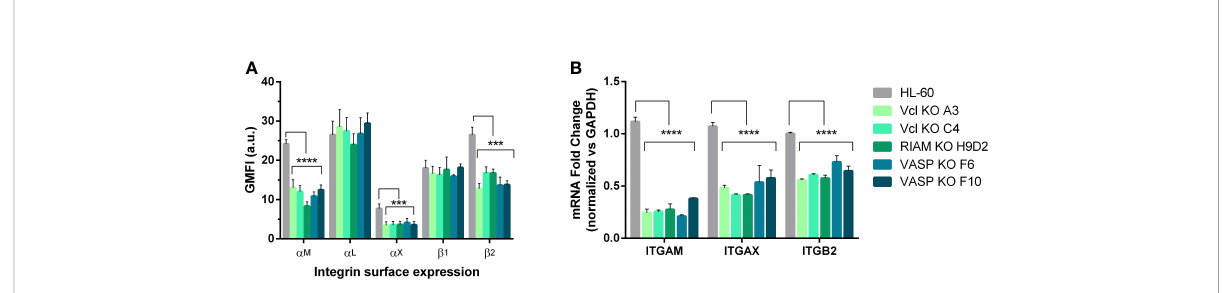
FIGURE 2 a a M and X expression is dependent on Vinculin, RIAM and VASP expression. (A) Vinculin (Vcl), RIAM and VASP knockout cell lines and HL-60 parental cells were differentiated into neutrophilic-like cells with 1 m M all- trans retinoic acid (RA) and stained with monoclonal antibodies speci fi c for a M , a L, a X, b 1 , b 2 integrin subunits. The geometric mean fl uorescence intensity (GMFI) was obtained by fl ow cytometry and data represented as relative to HL-60 levels and are from 24 independent experiments done in duplicate. (B) Expression of ITGAM ( a M ), ITGAX ( a X ), and ITGB2 ( b 2 ) mRNA levels was determined by RT-qPCR in neutrophil-like RIAM, VASP and Vcl HL-60 knockouts. Results are represented as relative to GAPDH mRNA and are from 3 independent experiments done in triplicate. Data are presented as mean ± SD, where the error bars denote standard deviation. Signi fi cance (ANOVA) has been calculated with respect to HL-60 controls, *** denotes p<0.005, and ****,